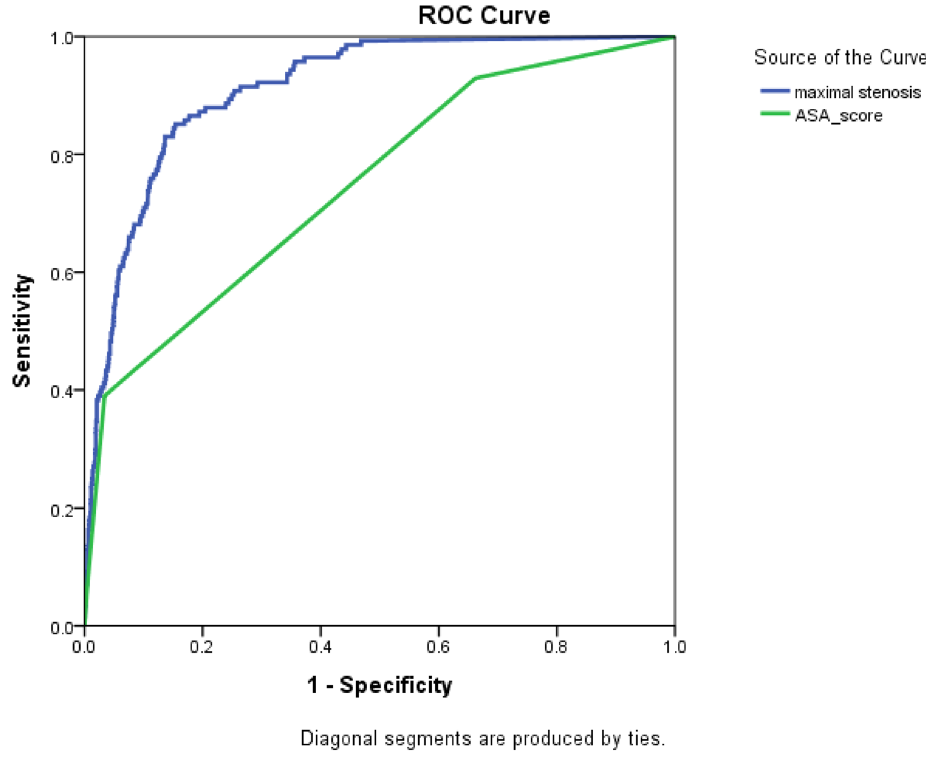
Figure 1. Receiver operating characteristic curve of the arterial stenosis degree for new-onset cardiovascular disease. The area under the curve of the ASA score is 0.747 and 0.911 for the maximal arterial stenosis. ASA American Society of Anesthesiologists Physical Status Classification